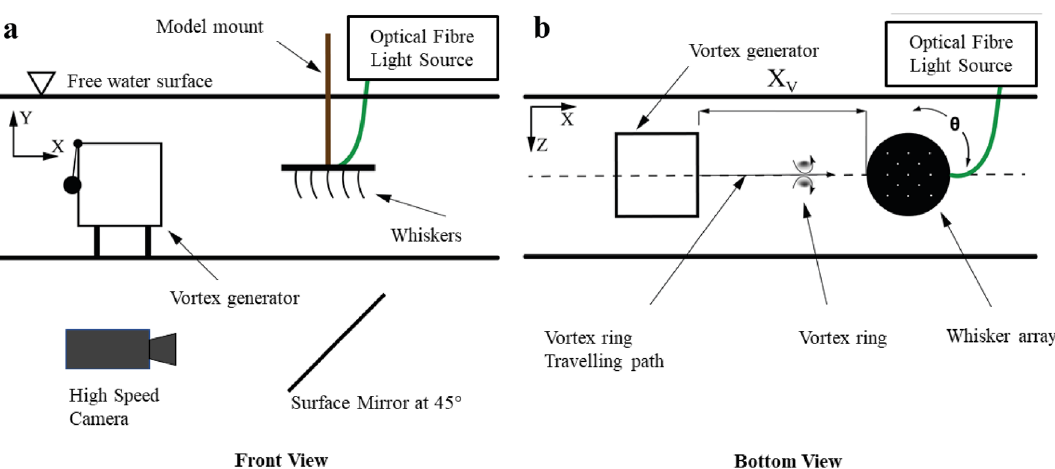
Figure 4. Schematic diagram of the 2D whisker array experimental set-up. To test different angles of impact within the array, the round disc housing the whisker array is rotated around its vertical axis. θ = ± 45 ◦